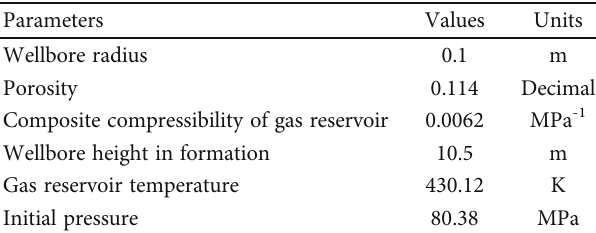
Table 2: Properties of gas reservoir.